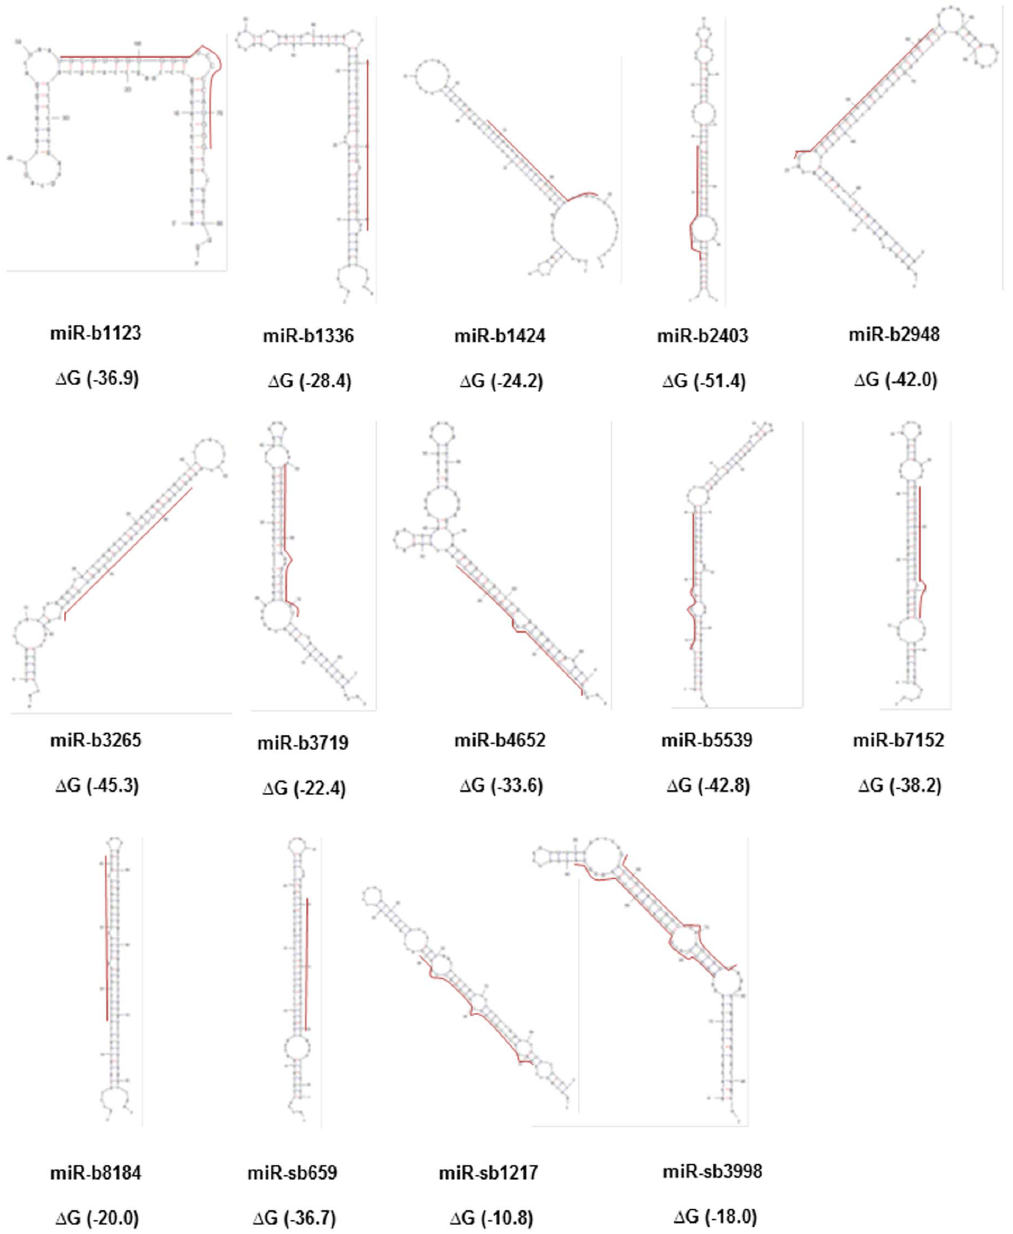
Figure 1. Predicted miRNA folding for putative novel miRNAs as determined using Mfold. Mature and/or star miRNA sequences are shown in capital letters and a line next to it for each hairpin precursor, when appropriate, according to expression. For pre-miR-sb659 and pre-miR- sb1217, only star sequences are highlighted, while for pre-miR-sb3998 both strands are in capital letters. D G (kcal/mol) for each hairpin structure is given in